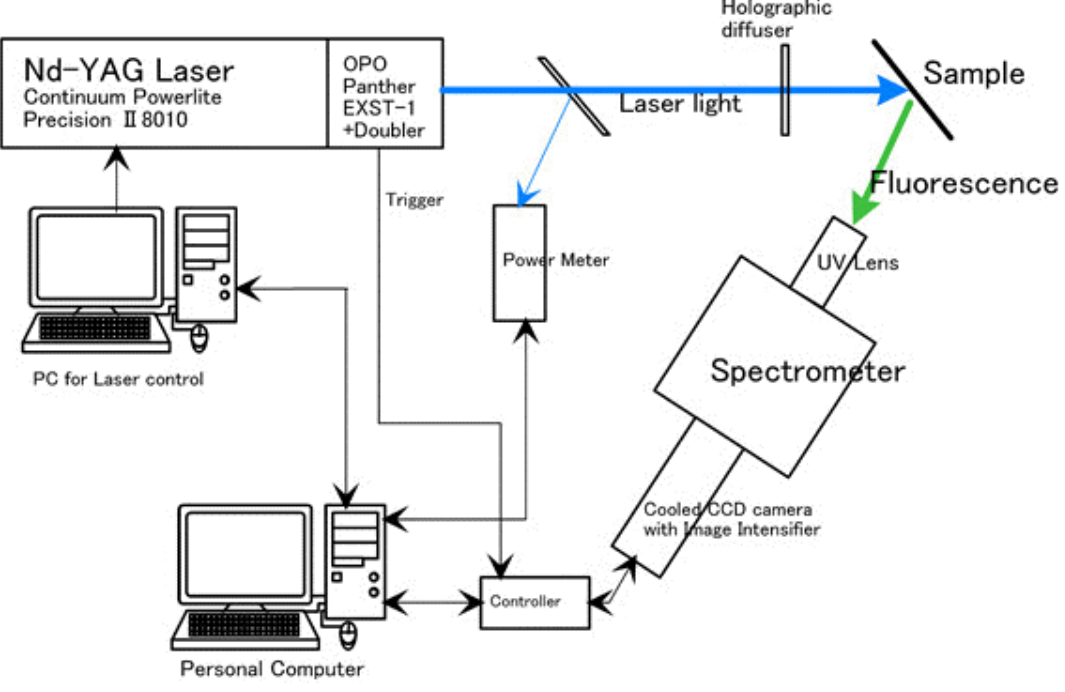
FIGURE 1. Block diagram of the time-resolving fluorescence imaging and spectroscopy